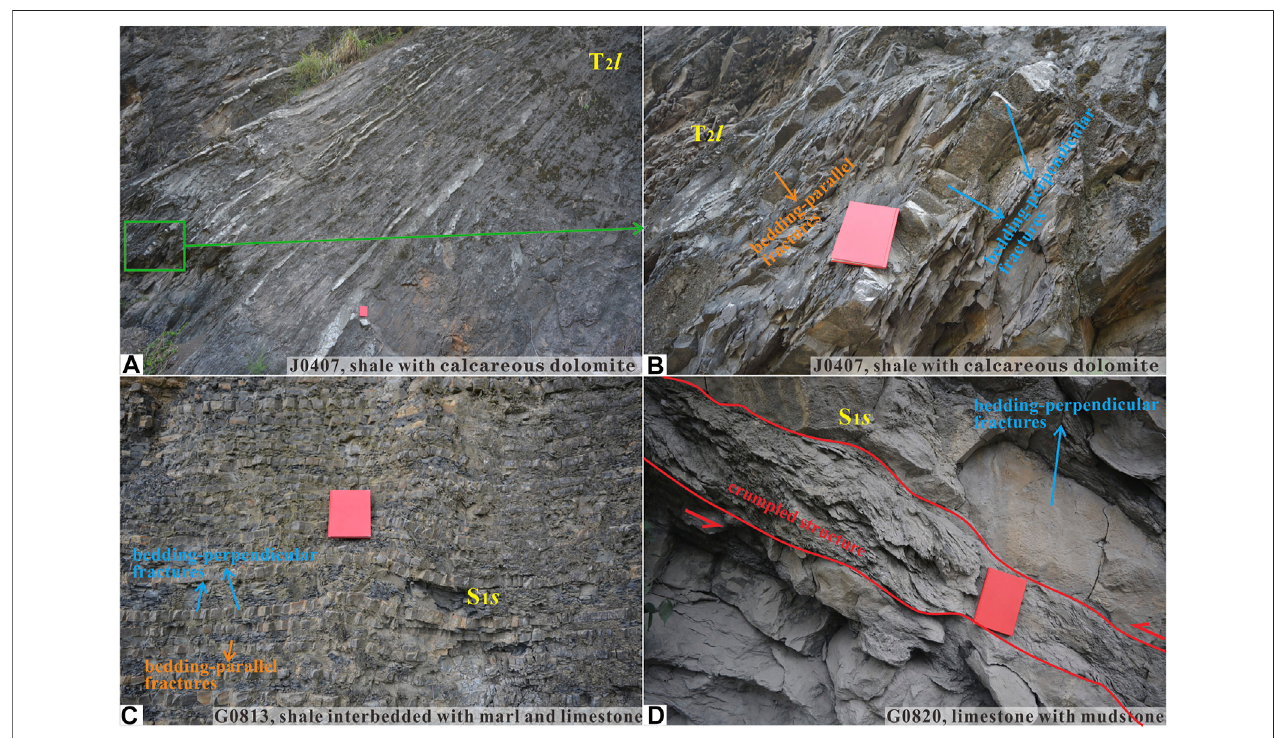
FIGURE 3 | Differences in tectonic fractures between soft and hard sublayers. Notes: (A,B) the observation point J0407, the Leikoupo Formation of the Middle Triassic (T 2 l ); (C) the observation point G0813, the Shiniulan Formation of the Lower Silurian (S 1 s ); (D) the observation point G0820, the S 1 s